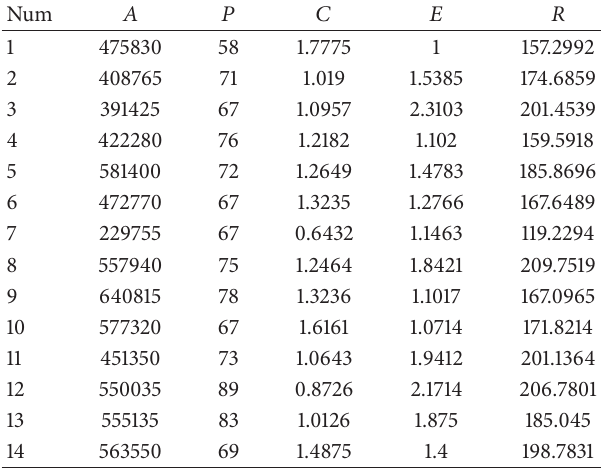
Table 1: Characteristic values of wheat